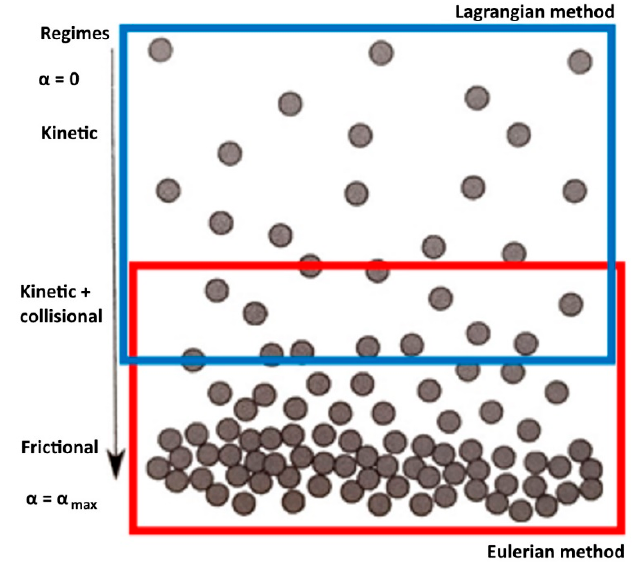
Figure 11. CFD modeling comparison [35].